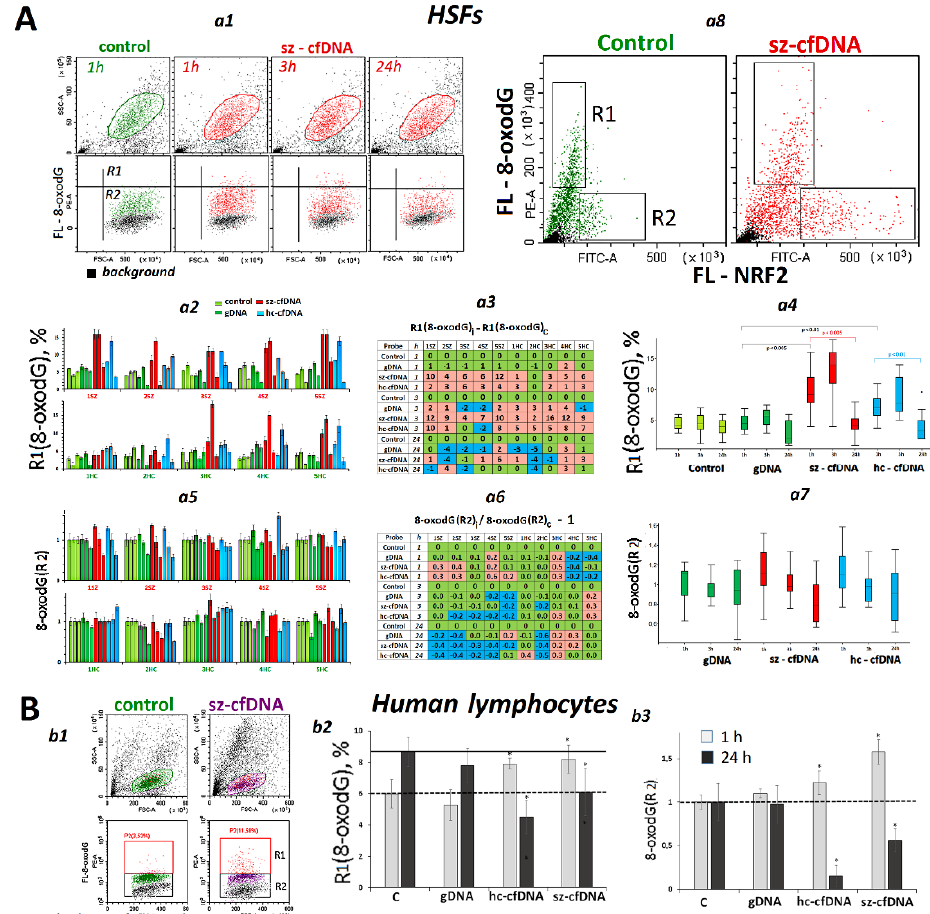
Figure 5. The influence of the DNA samples on the 8-oxodG levels in HSFs and PBL. ( A ). a1 —The most typical examples of the 8-oxodG assay with FCA in HSFs. The data from the device are given for sz-HSF2. a2 —Proportion of R1 fraction cells. a3 —Analysis of the changes in R1(8-oxodG) levels in the presence of DNA samples compared to control. a4 —Changes in the R1(8-oxodG) levels in sample of HSFs (n = 10). a5 —Index 8-oxodG(R2): the values of the medians of 8-oxodG(R2), normalized to the control signal value. Average values for three measurements and standard deviation are given. a6 —Analysis of relative changes in 8-oxodG(R2) levels in the presence of DNA samples compared to control. a7 —Changes in the 8-oxodG(R2) levels in sample of HSFs (n = 10). a8 —Dependence of R1(8-oxodG) on 8-oxodG(R2). ( B ). b1 —The most typical examples of the 8-oxodG assay with FCA in lymphocytes. b2 , b3 —Changes in the R1(8-oxodG) index and 8-oxodG(R2) index in sample of lymphocytes (n = 4). The asterisk * marks significant differences ( p < 0.01 when n = 10 and p < 0.05 when n =